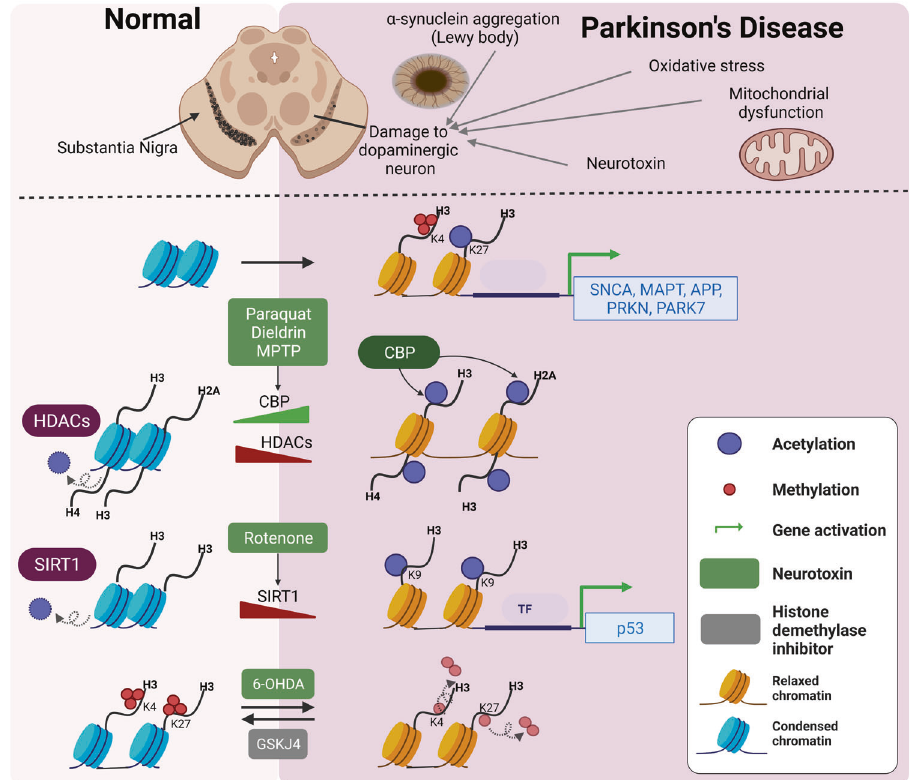
Fig. 6 Dysregulation of histone-modifying enzymes and histone modi fi cations in Parkinson ’ s disease (PD). Several neurotoxins induce H3 and H4 acetylation together with changing the expression of HATs and HDACs. For example, Paraquat and MPTP increase H3 and H4 acetylation. Dieldrin induces H3K14ac by increasing CBP expression. Rotenone reduces SirT1 expression levels, thereby increasing H3K9ac. Histone methylation is also dysregulated in PD. PD-related neurotoxin such as 6-OHDA reduces H3K4me3 and H3K27me3. Furthermore, H3K4me3 at the SNCA promoter is increased in PD